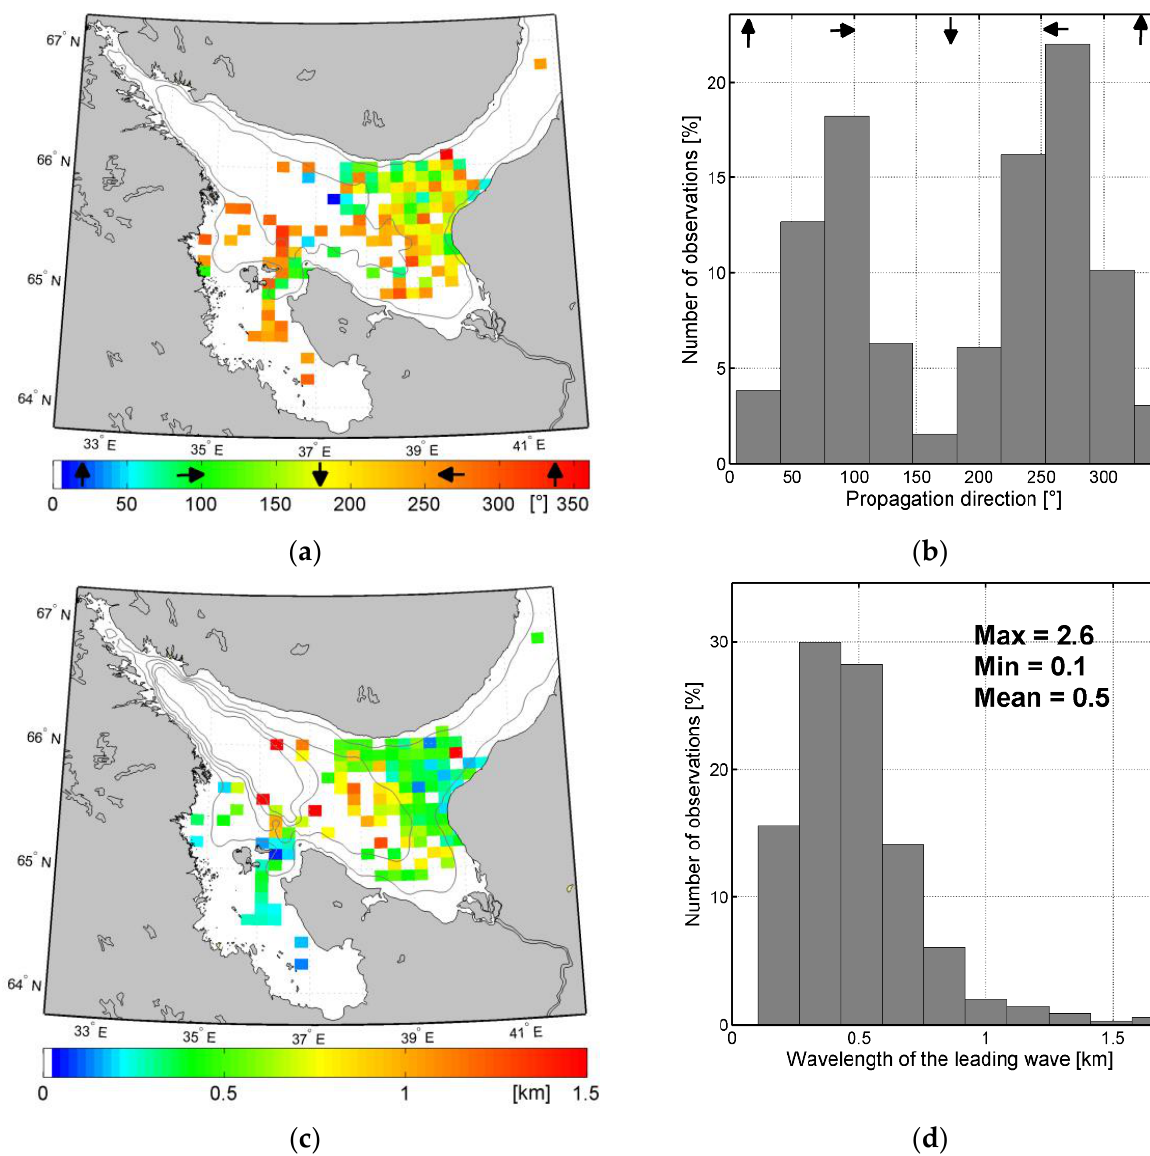
Figure 7. Spatial maps ( a , c ) and histograms ( b , d ) of ISW propagation direction ( a , b ) and wavelength of the leading wave ( c , d ).